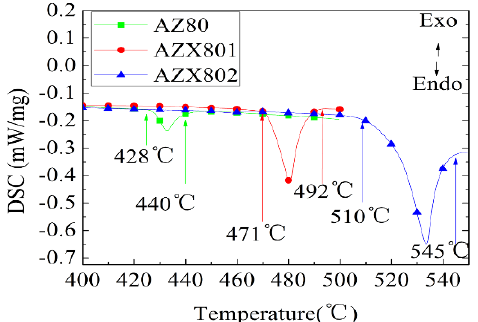
Figure 10. DSC analysis of AZ80, AZX801 and AZX802 at a heating rate of 10 °C/min. The onset point of the DSC valley represents the melting of the eutectic micro-constituent and the area of the valley represents the total heat absorbed to melt the eutectic micro-constituent.